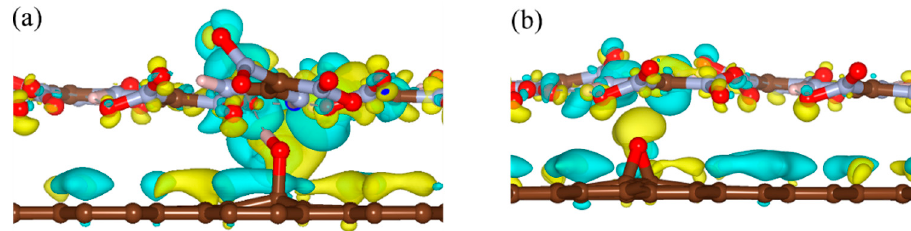
Figure 3. Charge density differences of ( a ) FOX-7–G–OH and ( b ) FOX-7–G–O composites. Isosurface levels were set at 0.0015 Bohr − 3 ; cyan: charge accumulation; yellow: charge depletion.